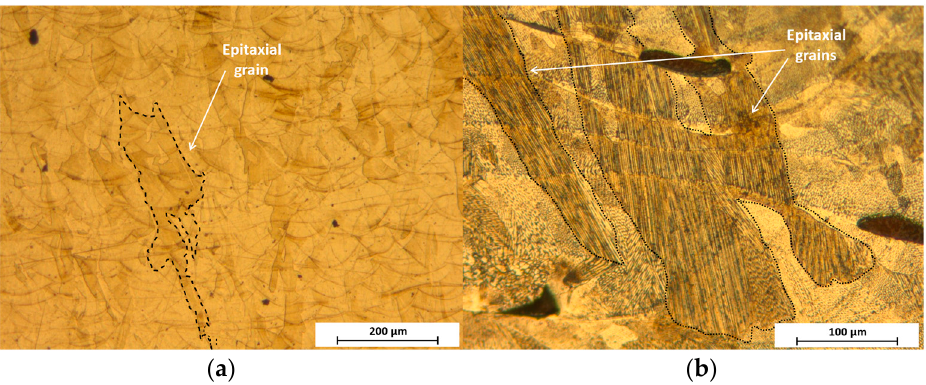
Figure 7. Optical micrograph: ( a ) FL–SLM sample; and ( b ) CO 2 –SLM